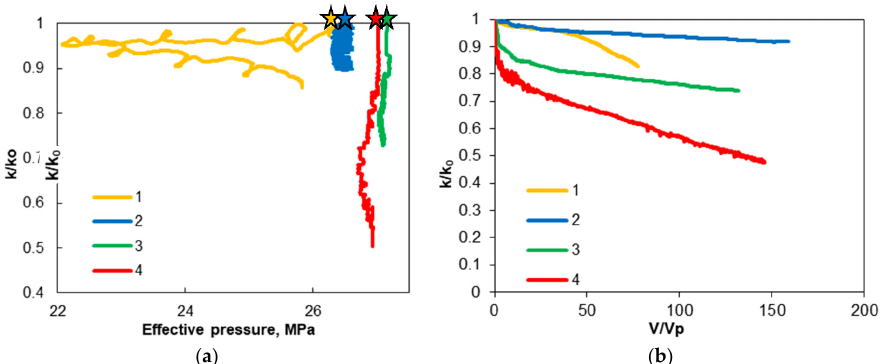
Figure 7. Dynamics of relative permeability on effective pressure ( a ) and injected volume ( b ) during coreflooding. The numbers correspond to the sample numbers. The stars correspond to the initial permeability values.